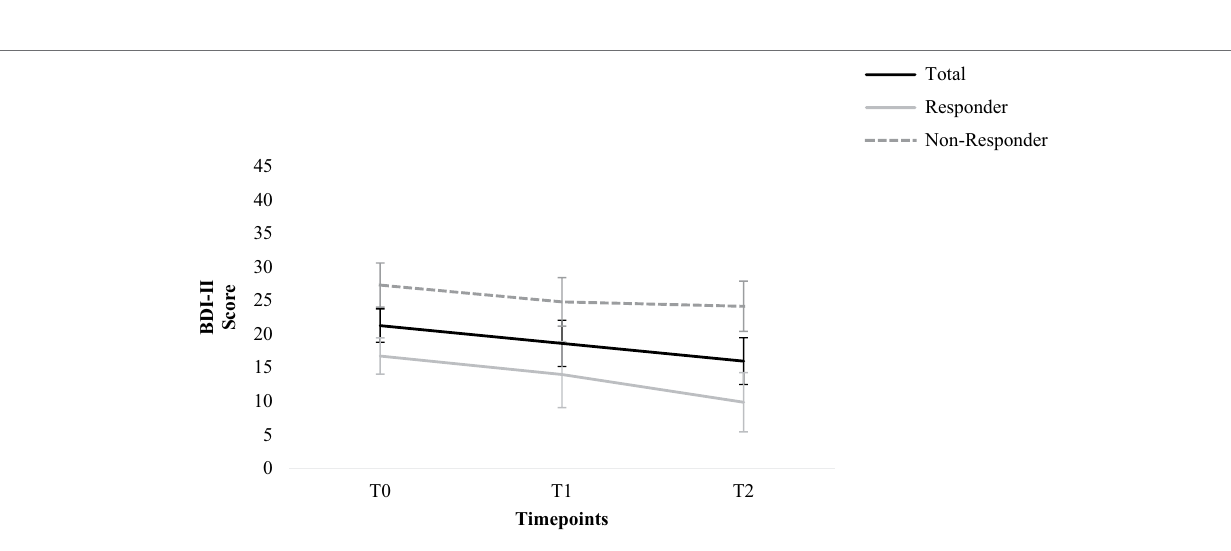
FIGURE 3 | Change in the Beck Depression Inventory-II score for total sample, responders, and non-responders. Error bars represent standard